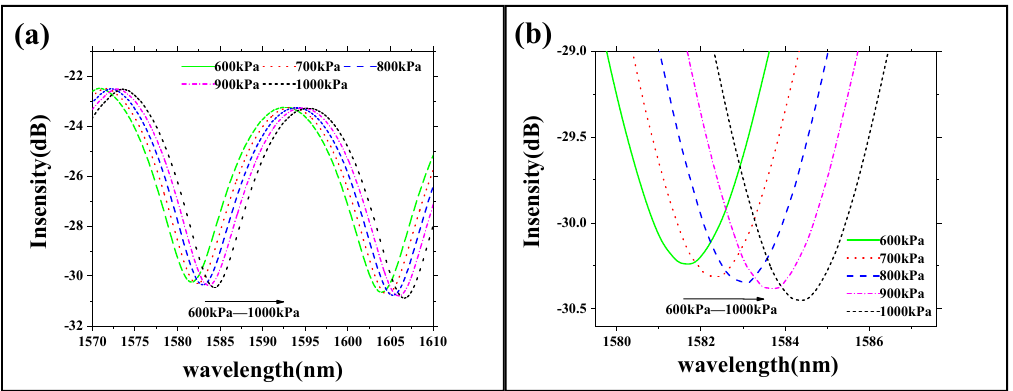
Figure 10. ( a ) The movement of the interference spectrum under pressure changes of 600~1000kPa. ( b ) Local amplification of interference peak.